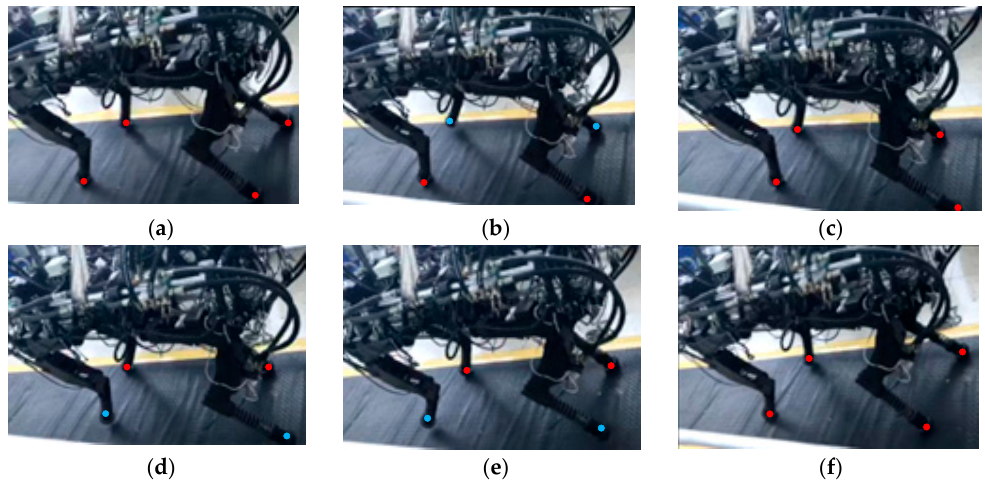
Figure 11. The pacing gait motion of the hydraulic quadruped robot in a gait period. ( a ) Initial stage. ( b ) RF and RH leg are in the support stage. ( c ) All legs are in the supporting stage. ( d ) RF and RH leg are in the lifting stage. ( e ) RF and RH legs are at their highest points. ( f ) Touch down stage.